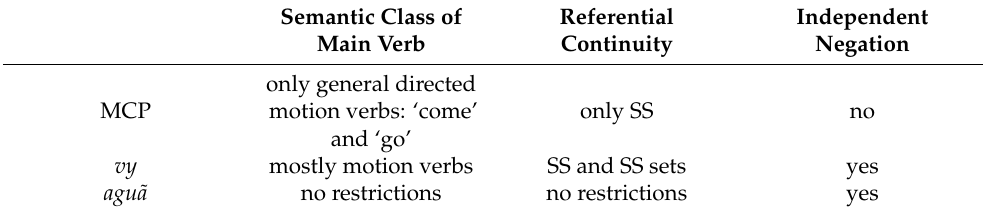
Table 2. Integration within the main clause in Mbya purpose coding strategies. Semantic Class of Referential Independent Main Verb Continuity Negation only general directed MCP motion verbs: ‘come’ only SS no and ‘go’ mostly motion verbs SS and SS sets